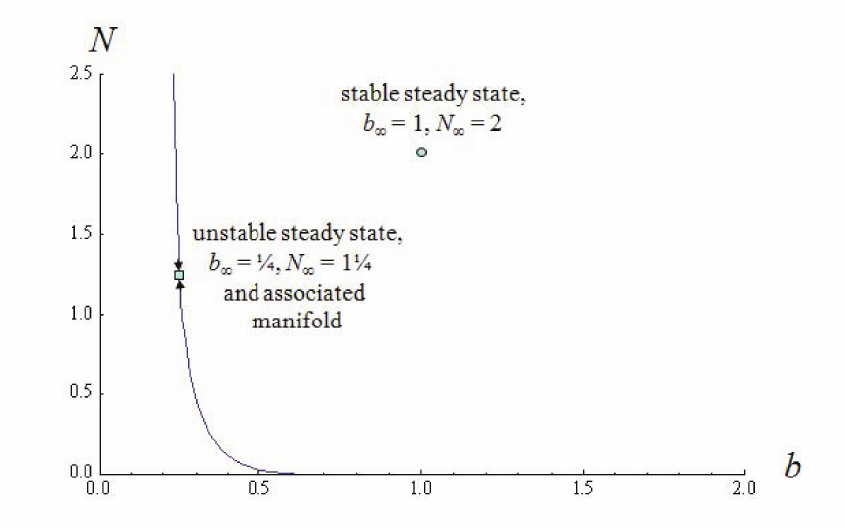
= 0 . 1 , p = 1 , k = 2 , v = 2 . 5 min